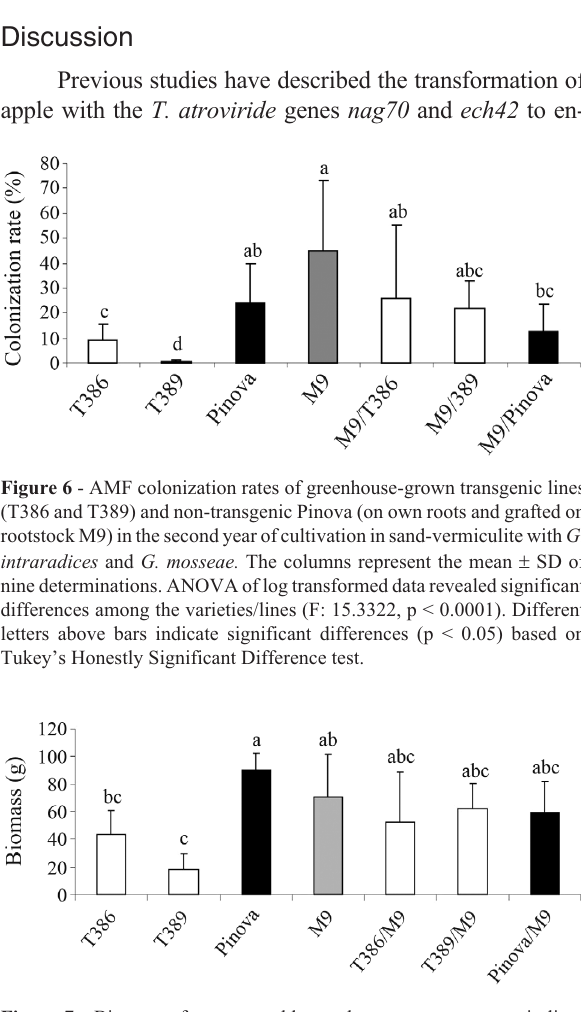
Figure 7 - Biomass of two-year-old greenhouse-grown transgenic lines (T386 and T389) and non-transgenic Pinova (on own roots and grafted on rootstock M9) . The columns represent the mean (cid:3) SD of 4-5 determina- tions. ANOVA revealed significant differences among the varieties/lines (F: 5.0944, p = 0.0017). Different letters above bars indicate significant differences (p < 0.05) based on Tukey’s Honestly Significant Difference